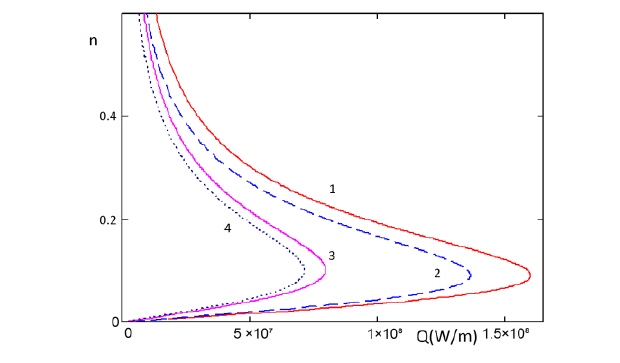
Figure 3. The NLSP propagation constant n vs. the NLSP total energy flux Q. The saturation level